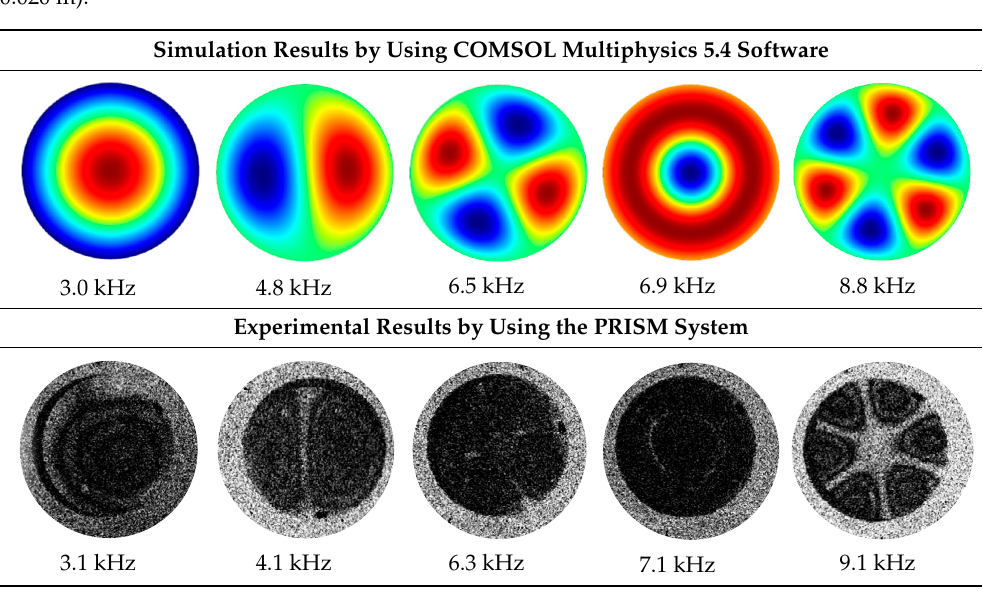
Table 2. Surface displacement field of the membrane at different frequencies (at 200 V, with radius 0.020 m).